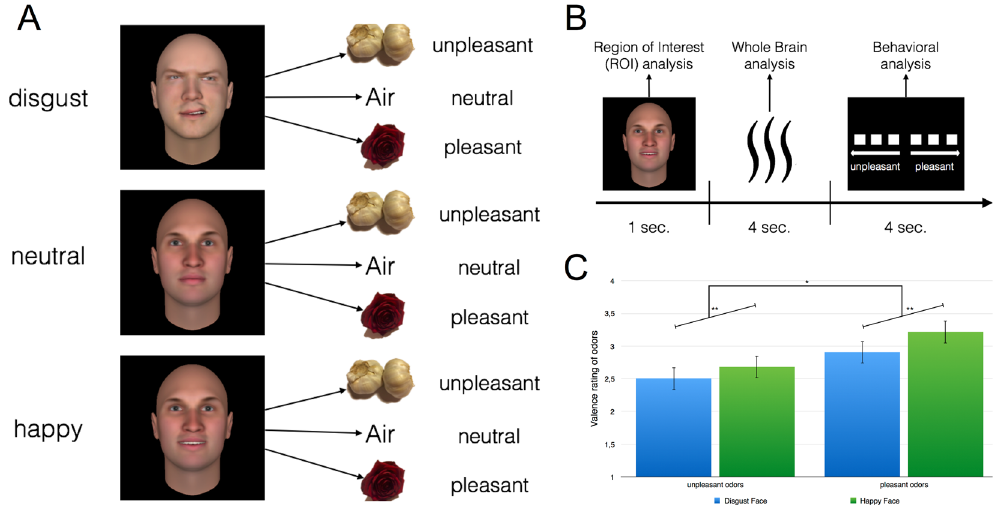
Figure 1. Experimental design and behavioral data. ( A ) Disgusted, neutral and happy facial expressions from the Bochumer Emotional Stimulus Set 10 were used. Each facial expression was paired with an unpleasant, neutral or pleasant odor. ( B ) For each run, subjects were presented with an emotional facial expression (disgusted, neutral or happy) for 1 seconds, followed by an odor (unpleasant, neutral or pleasant) for 4 seconds, which in the following had to be rated for its valence within 4 seconds. Region of interest analysis was conducted for visual presentation of facial expressions before odor presentation. For odor presentation, a whole